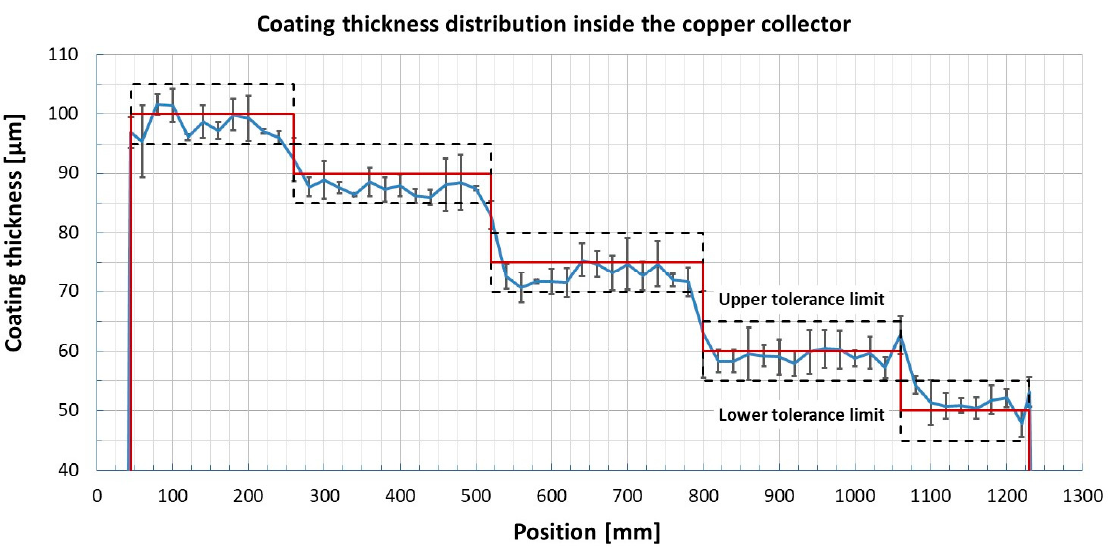
Figure 12. Coating thickness distribution measurement (blue line) of the coated copper collector; also shown are desired values of coating thickness (red line) and tolerance limits (black dotted lines).